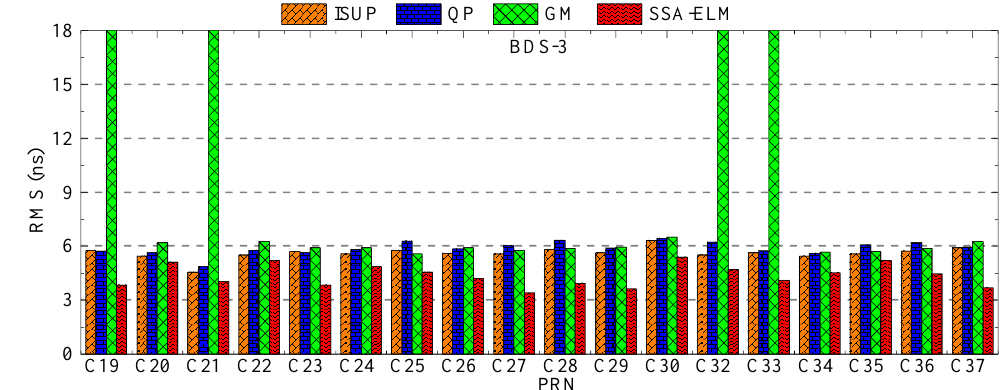
Figure 22. Multiday average prediction accuracy of BDS-3.